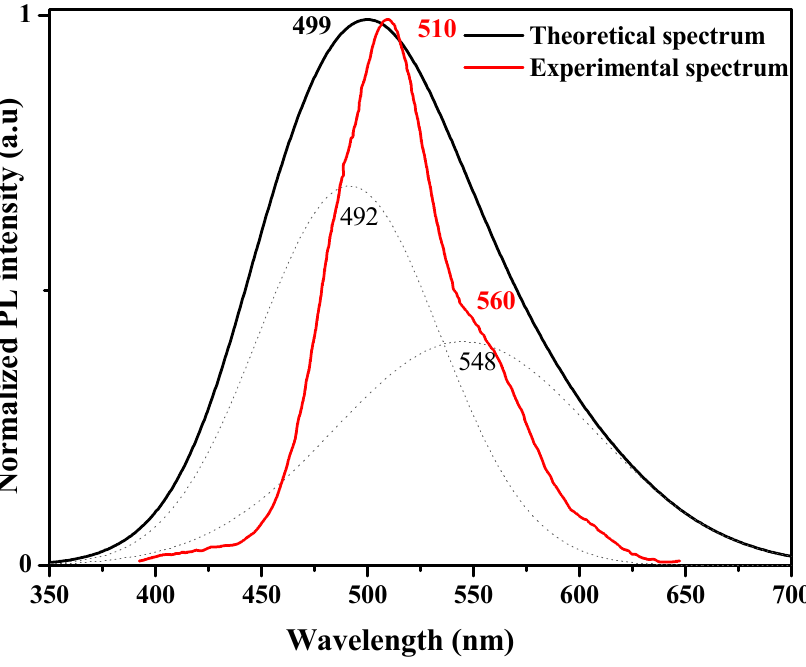
Figure 9. PL spectra of PVK-F8T2 copolymer.